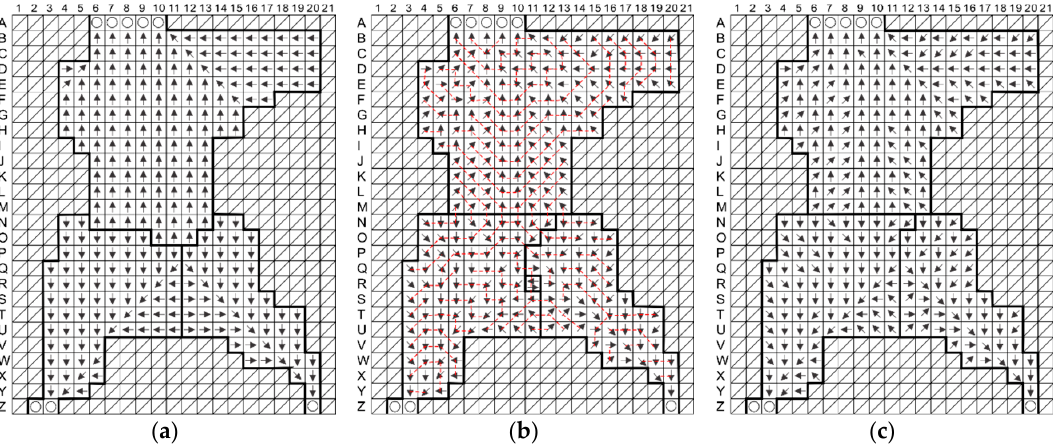
Figure 11. Flow directions after flat correction determined by ( a ) JD method in ArcGIS (ESRI, Redlands, CA, USA); ( b ) DEDNM, and ( c ) the new algorithm (the arrows indicate flow directions; the cells with a red dash line have the same elevation; and the dark solid lines show drainage boundaries).